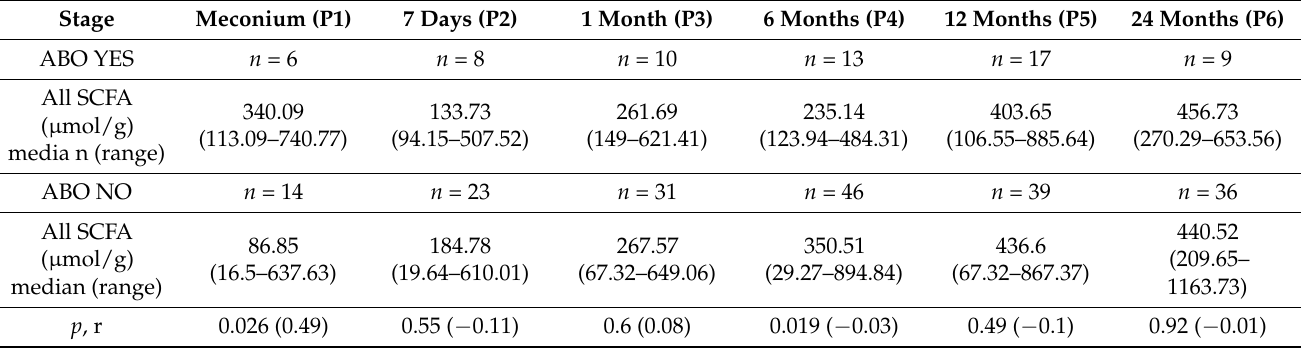
Table 4. Effects of antibiotic therapy during pregnancy on all SCFA concentrations.